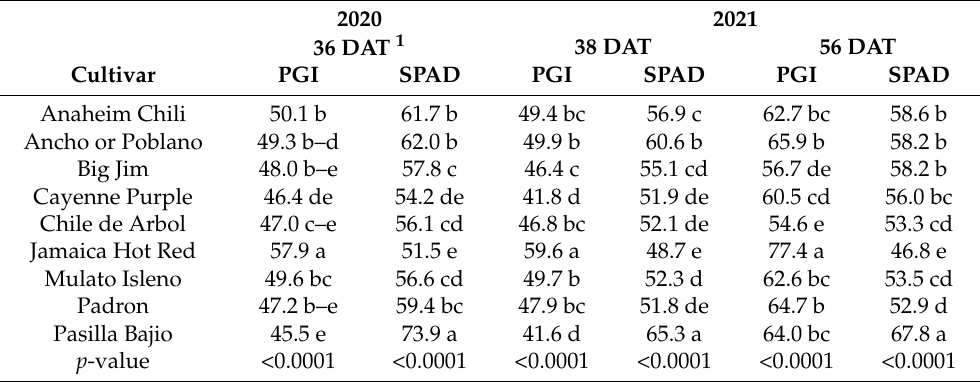
Table 1. Plant size and leaf SPAD of nine heirloom chile pepper cultivars were measured once in 2020 and twice in